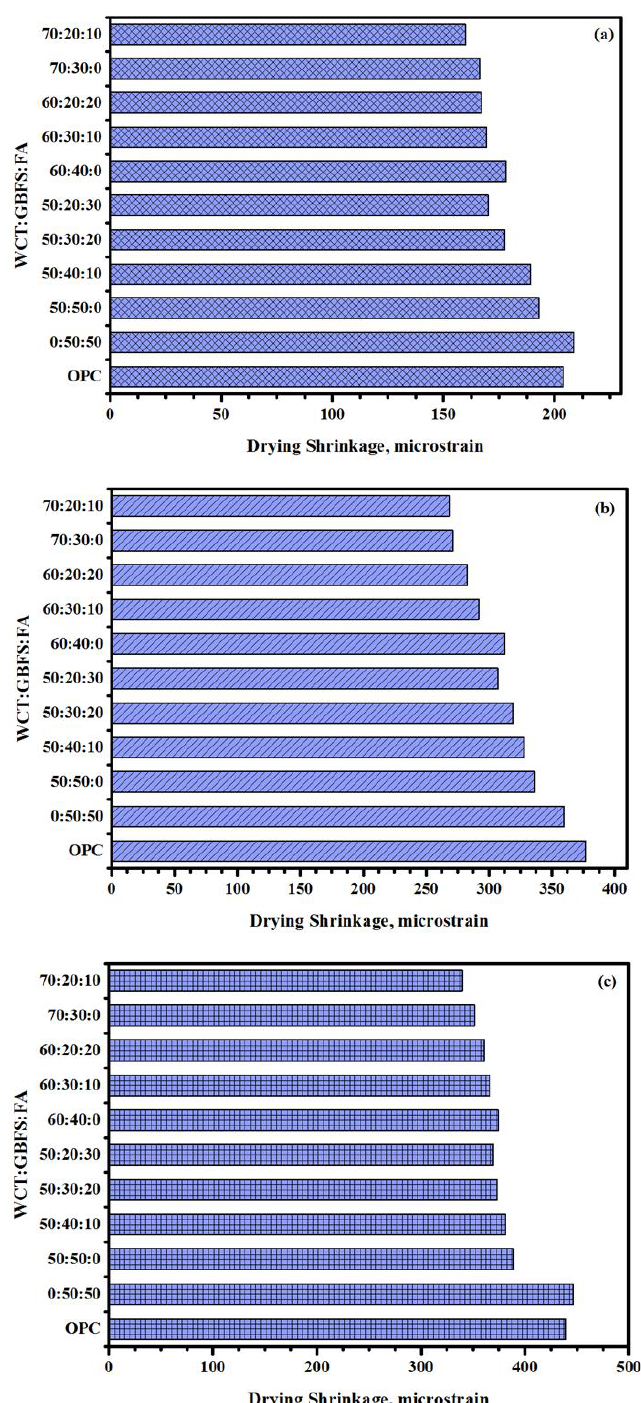
Figure 14. Effects of various WCT content levels on the drying shrinkage of GPMs at early and late ages ( a ) 3 days, ( b ) 28 days, and ( c ) 180 days.